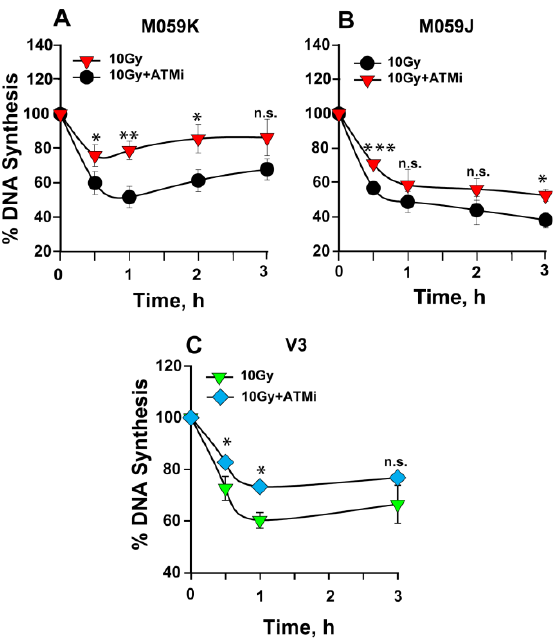
Figure 4. ATM has only a small contribution to the persistent intra-S-phase checkpoint in DNA-PKcs–deficient cells. ( A ) Percentage of DNA synthesis over non-irradiated controls measured after exposure to 10 Gy of IR in the presence or absence of ATMi in M059K cells. ( B ) As in ( A ) in M059J cells. ( C ) As in ( A ) in V3 cells. Error bars represent the standard deviation from 3 independent experiments. The significance of differences between individual measurements is indicated by * symbol: * p < 0.05, ** p < 0.01, *** p < 0.001; n.s. non-significant.